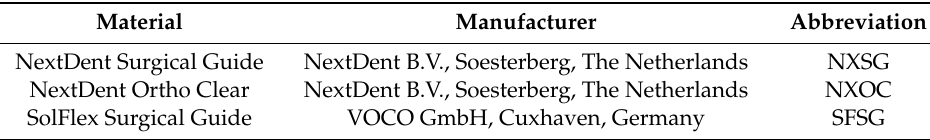
Table 1. 3D printing materials used in this study.